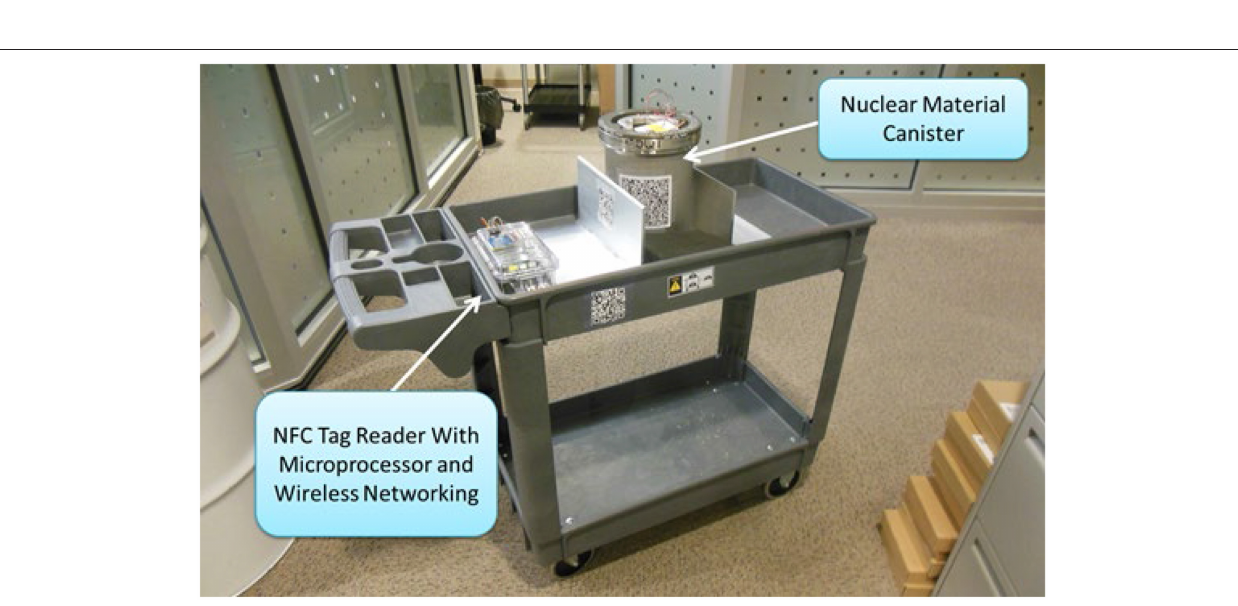
FIGURE 4 | The smart cart used to electronically document the movement of nuclear materials. That smart cart features an NFC tag reader, microprocessor, and wireless networking capabilities.